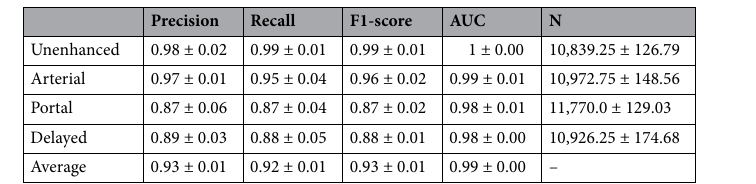
Table 4. Performance metrics in the testing set for the volumes evaluation using the best model found by the Hyperparameter Tuning.